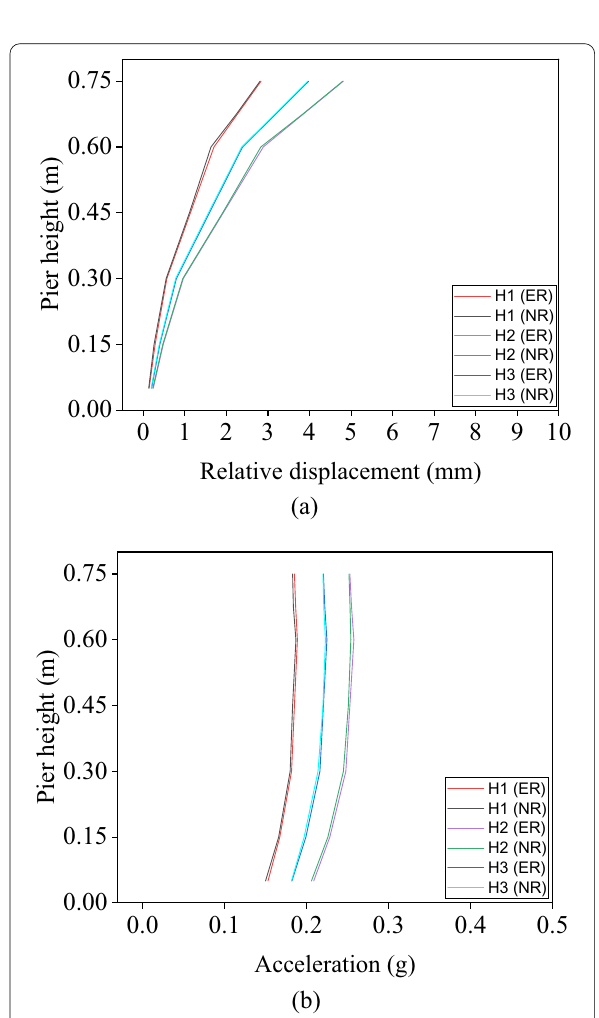
Fig. 13 Experimental results (ER) and Numerical results (NR) under structure orientation ( 0 ◦ )